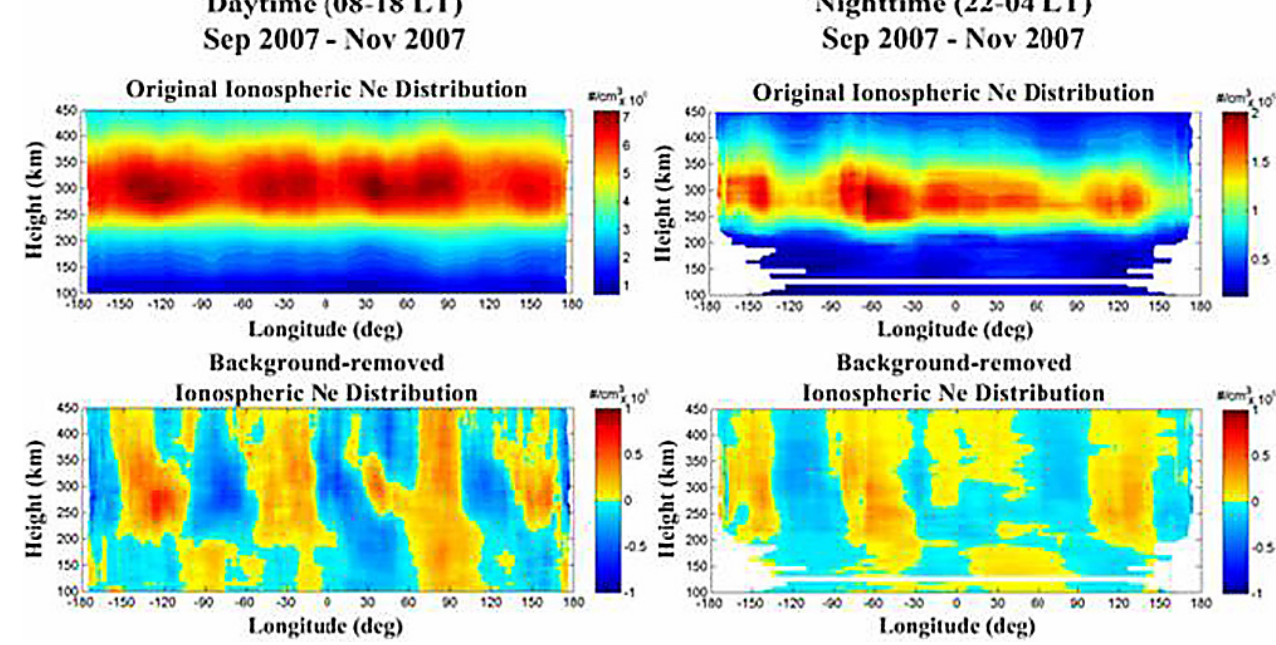
Fig. 1. Example of height versus longitude distributions of original (upper panels) and background-removed (lower panels) ionopsheric electron densities along the equator for the period September–November 2007, in which daytime (08:00–18:00LT) (left panels) and nighttime (22:00–04:00LT) (right panels) averages were, respectively, demonstrated for